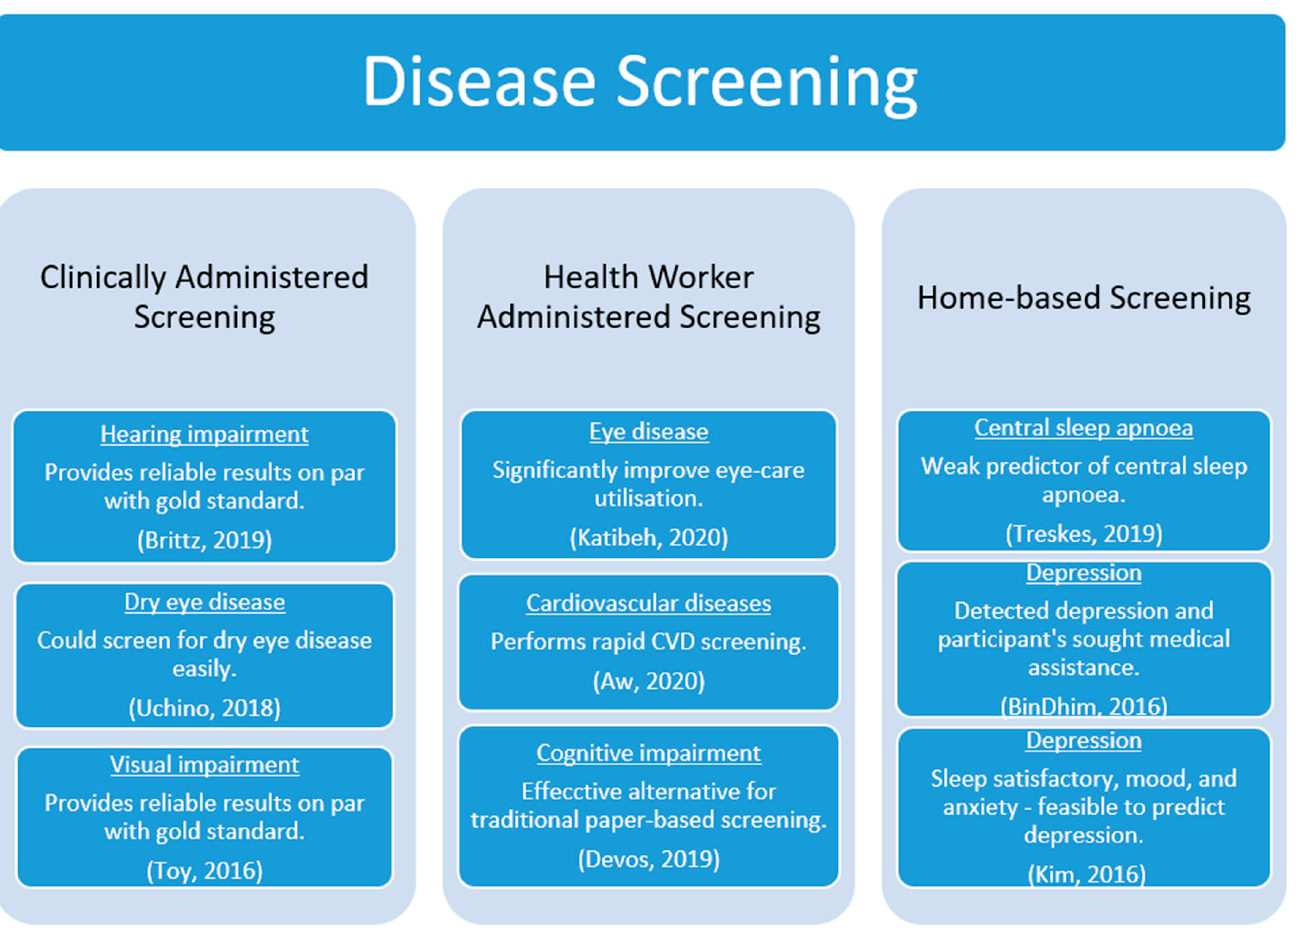
Figure 3. Disease screening and significant outcomes .